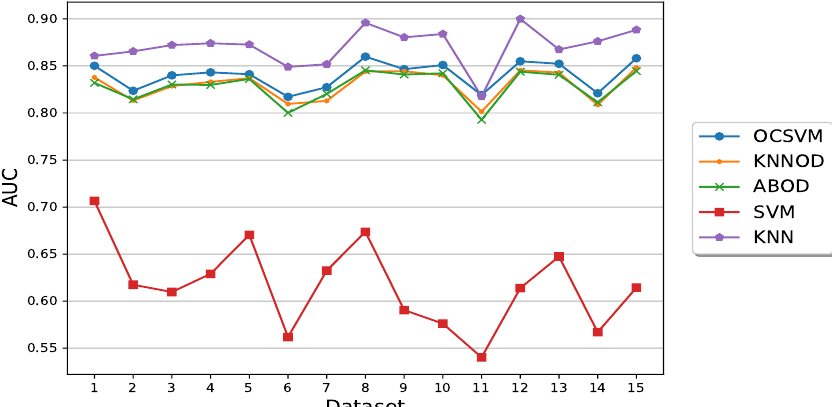
Figure 14. Performance comparison of semi-supervised and supervised algorithms in terms of average